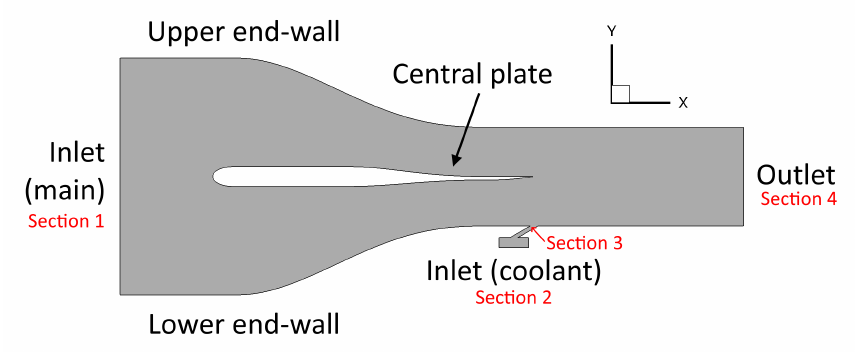
Figure 1. Control volume of the numerical simulation.